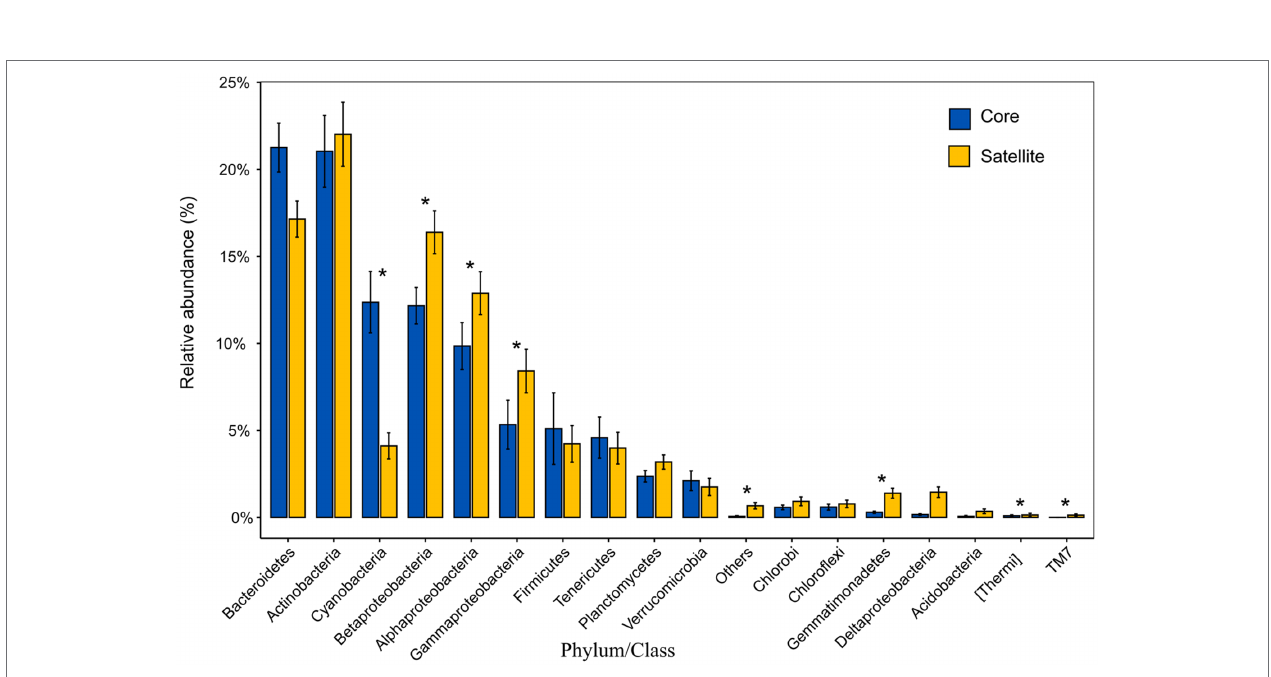
FIGURE 1 | Distribution (A) and dispersion (B) of the core and satellite OTUs in the Tibetan lakes. (A) The OTU occurrence (number of samples in which a given OTU was detected) plotted against the mean relative abundance of each OTU across samples. The red line represents the linear regression model fit to species abundance distribution. (B) The OTU occurrence plotted against the index of dispersion for each OTU calculated as variance to mean ratio of abundance for each OTU. The red line represents 2.5% confidence limit for the χ 2 distribution.